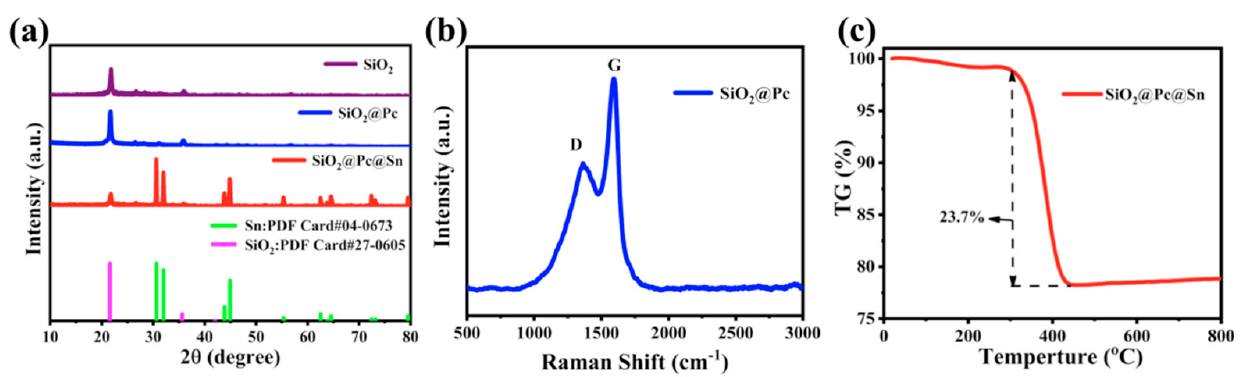
Figure 2. ( a ) XRD patterns of different samples; ( b ) Raman spectrum of SiO 2 @Pc; ( c ) thermogravimetry (TG) diagram for the SiO 2 @Pc.